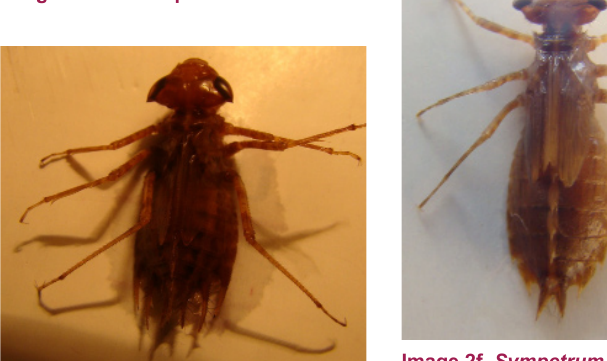
Image 2f. Sympetrum sp.